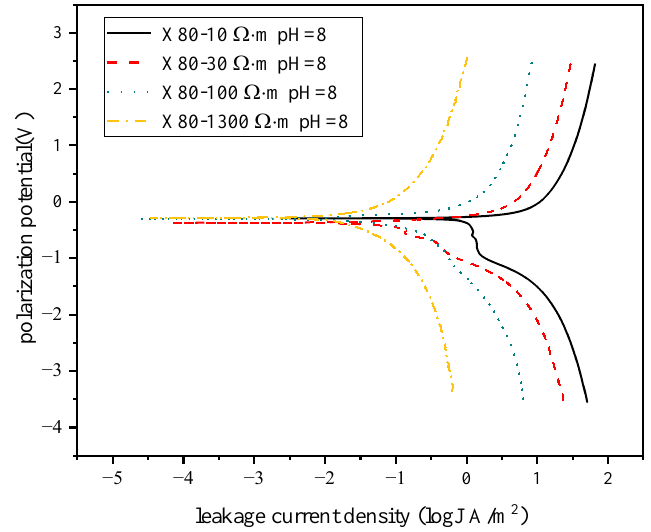
Figure 14. Polarization curve under different soil resistivity.